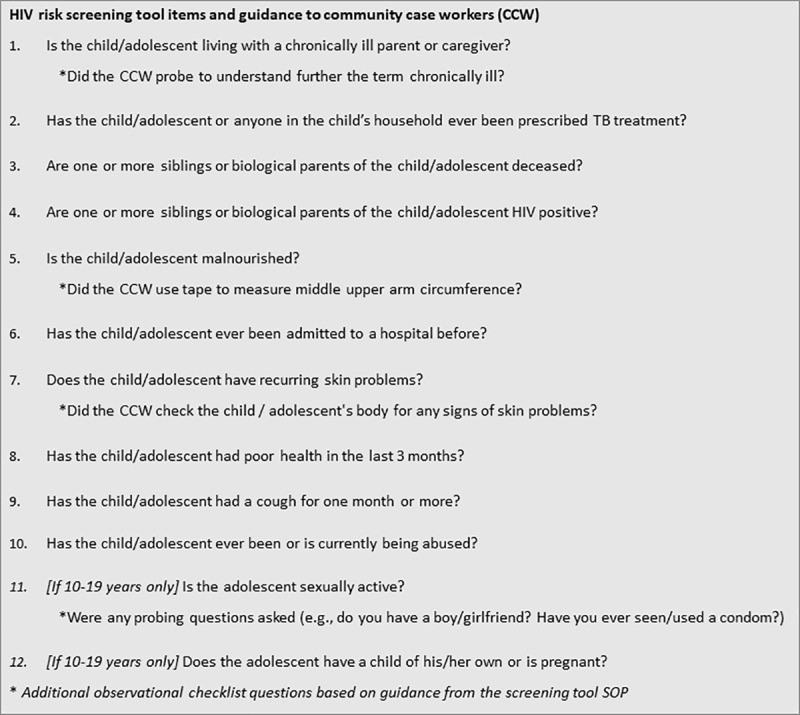
HIV risk screening tool items and guidance to Community Case Workers (CCW).